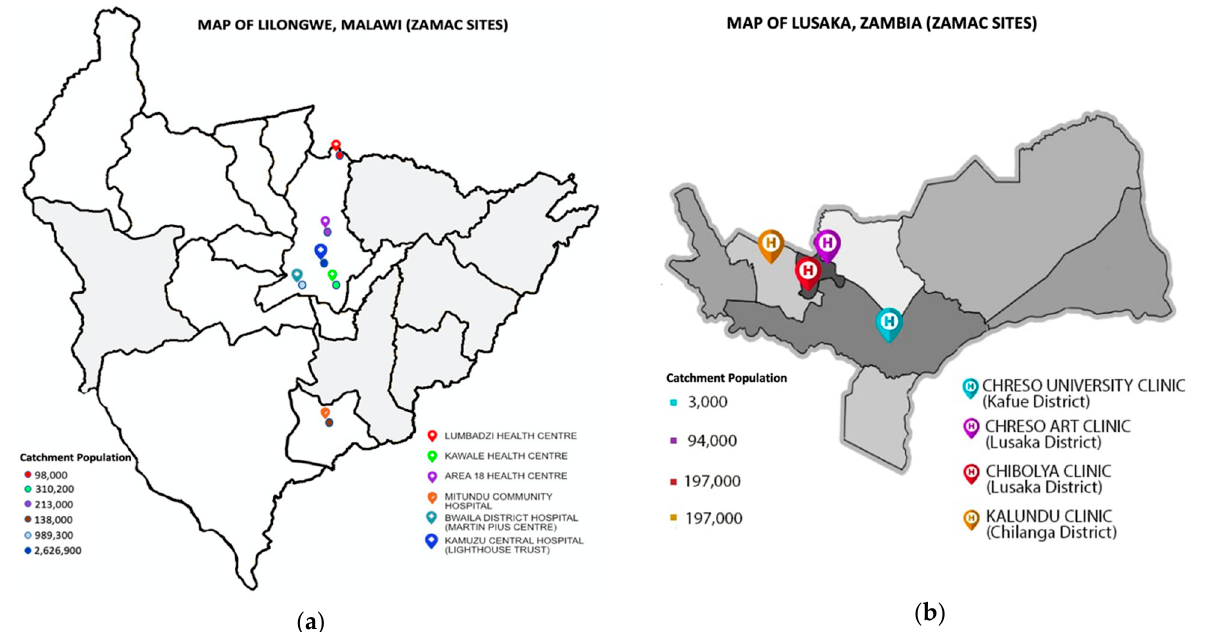
Figure 1. Locations ( a , b ) of target primary healthcare sites and their catchment populations [31].